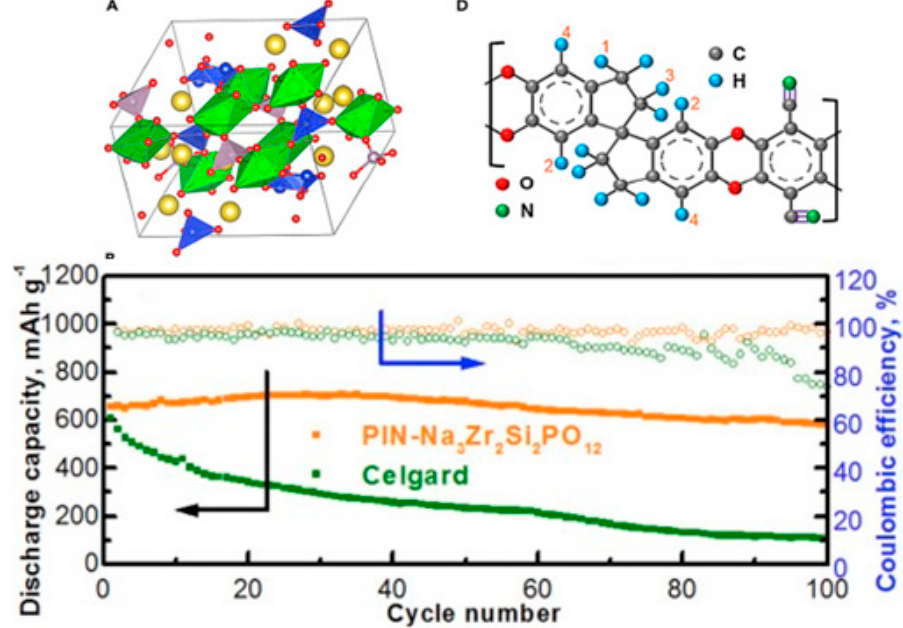
Figure 4. Illustration of the NASICON structure of Na 3 Zr 2 Si 2 PO 12 material and molecular structure of a polymer with intrinsic porosity (PIN) and specific discharge capacities and Coulombic efficiencies versus cycling number of a Na || PIN [17]. Reprinted with permission from Yu, X.; Manthiram, A. Sodium-SulfurBatterieswithaPolymer-CoatedNASICON-typeSodium-IonSolidElectrolyte; copyright 2019 from